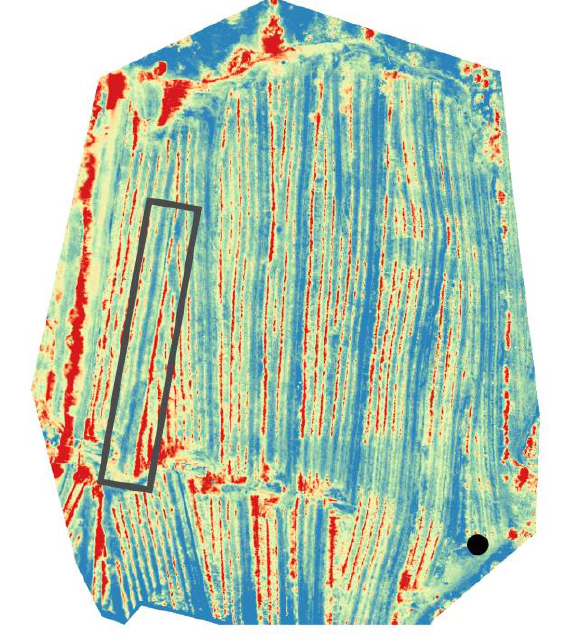
Figure 3: TIR orthoimages of the Lamole vineyard in the Chianti region (Italy), recapture at morning. Soil temperature was 17.4°C (black dot), air temperature 15.6°C and R.H. 95.8%. The rectangular frame represents an area with about 3.5-4°C of difference between internal row (in blue, colder and facing the dry-stone wall) and the external row (in red, warmer and placed on the top of the dry-stone wall)